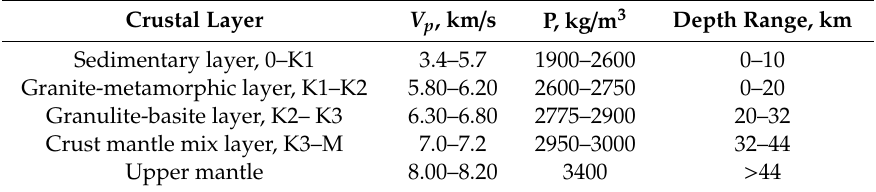
Table 1. The four-layered velocity model of the White Sea Region’s earth